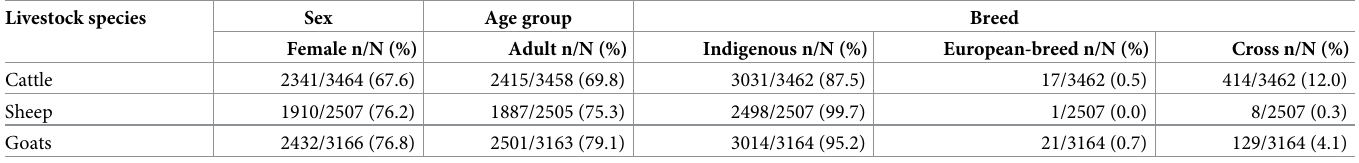
Table 3. Sex, age and breed characteristics for cattle, sheep, and goat data. Livestock species